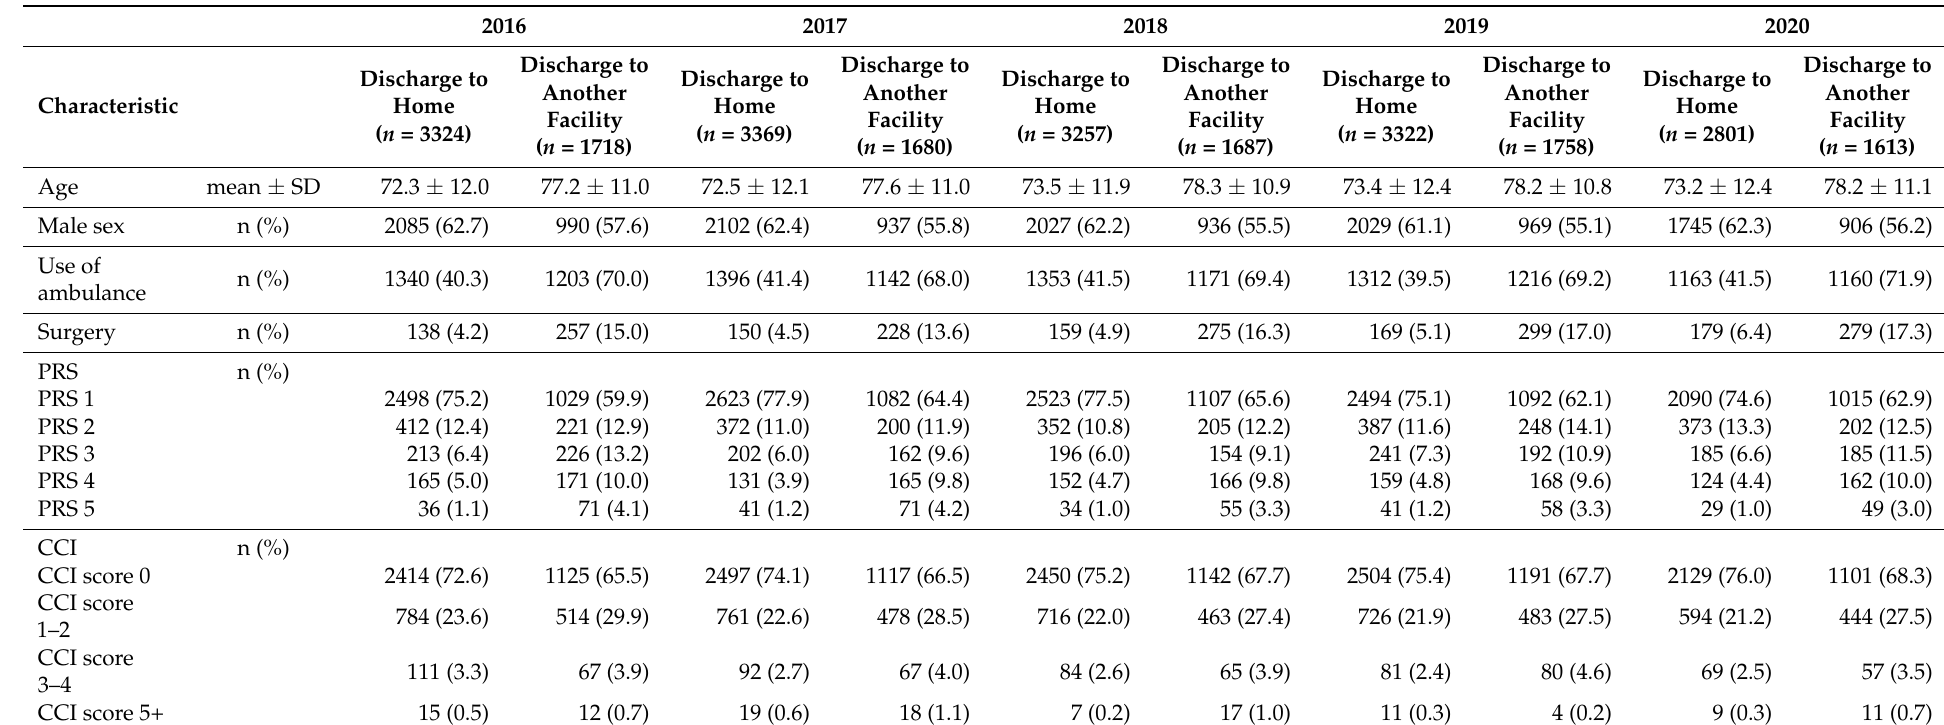
Table 2. Demographic characteristics of patients in single-year HSHR